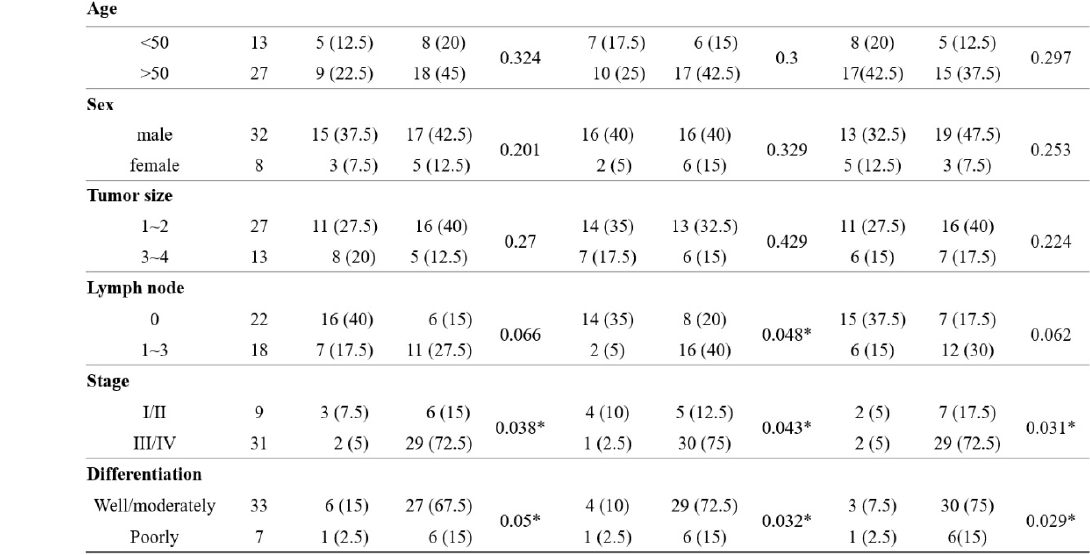
Figure 5. Immunohistochemical analysis of IL-33 and CXCR4 expression and the clinical implications of the IL-33/CXCR4 signaling circuit in 40 patients with HNSCC. ( a ) Photomicrographs of immunohistochemical staining IL-33 and CXCR4 expression in the HNSCC patients. Twenty-two patients (55%) showed negative or low expression of IL-33, 18 patients (45%) showed a positive immunoreactivity of IL-33 expression, 13 patients (32.5%) showed negative or low expression of CXCR4, and 27 patients (67.5%) showed positive immunoreactivity of CXCR4 (magnification, × 200). ( b ) The linear regression analysis of IL-33 and CXCR4 expression showed a significant correlation of IL-33 expression with CXCR4 expression ( p = 0.027). ( c ) The Kaplan–Meier analysis of disease-free survival of HNSCC patients after a 60-month follow-up plotted as patients who showed negative immunoreactivity versus positive immunoreactivity for IL-33 and CXCR4 expression in tumor cells. Patients negative for IL-33 and CXCR4 expression had a longer disease-free survival compared with those who tested negative for IL-33 and positive for CXCR4. The co-expression of IL-33 and CXCR4 in HNSCC cells showed a